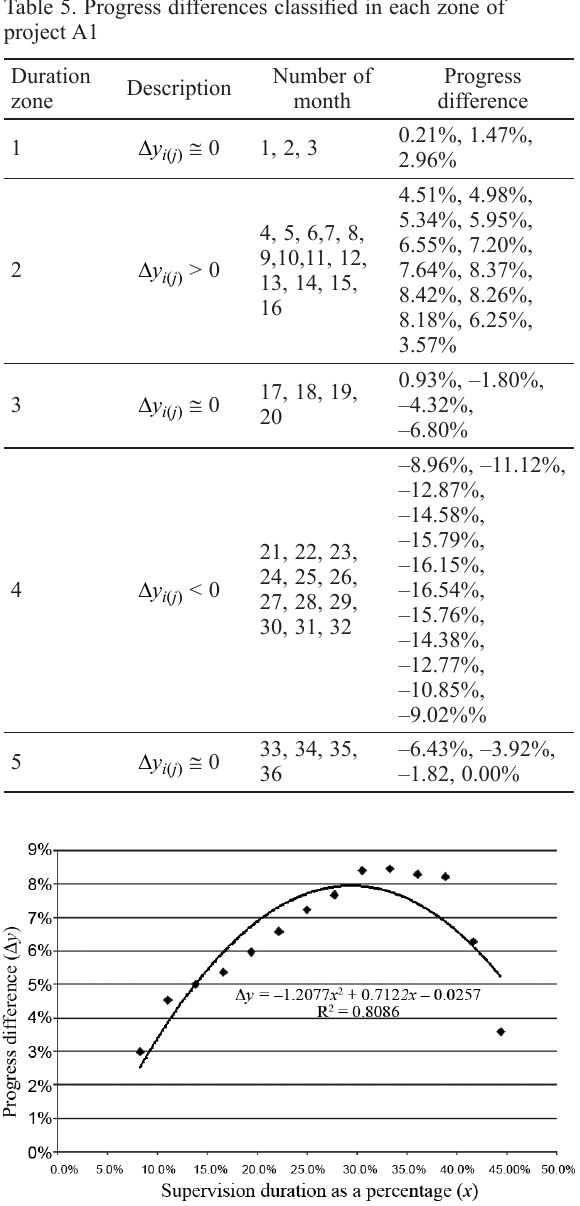
Fig. 4. Regression line for fitting the data of progress differences in zone 2 of project